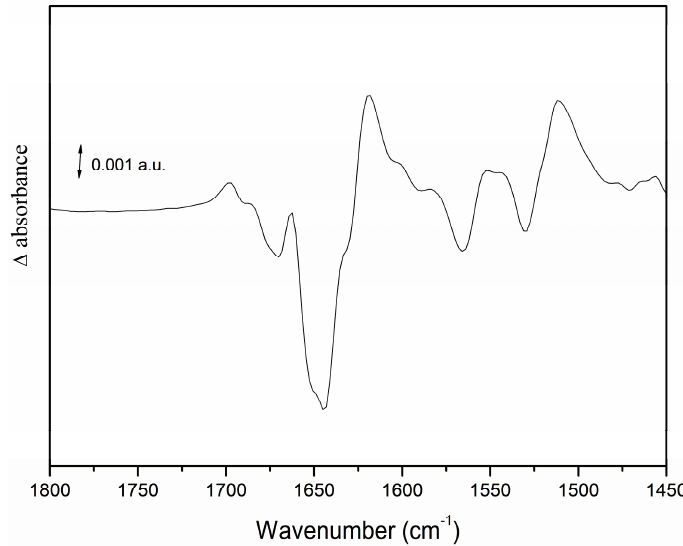
Figure 8. Light-induced FTIR difference spectra on wild-type OCP. See text for further